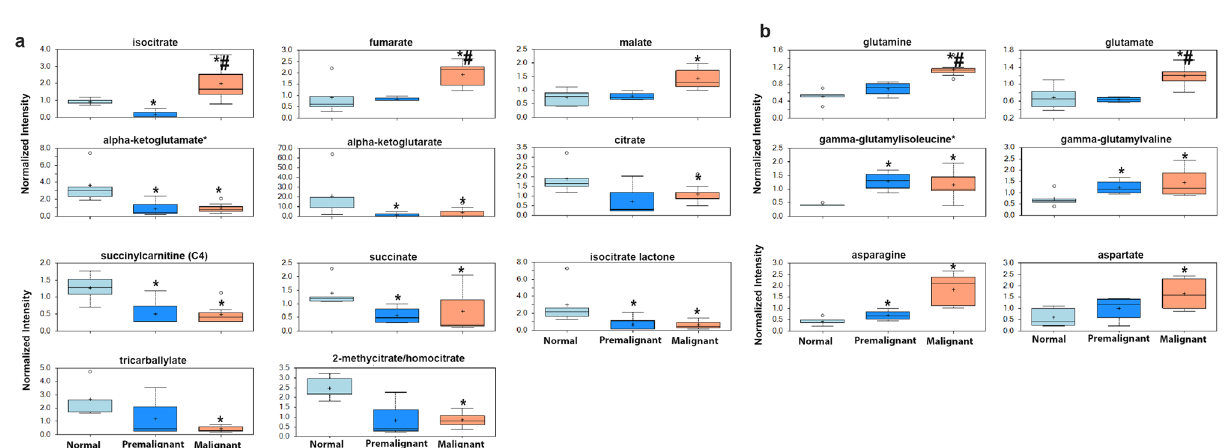
Figure 9. Glycolysis in premalignant and early malignant bladder lesions: ( a ) The expression of glucose and glycolysis intermediate and end metabolites. * p < 0.05 compared to normal. # p < 0.05 comparing premalignant to malignant lesions. ( b ) Transcript expression of HK2 and SLC2A1 (glucose transporter 1) in NMI tumors compared to normal urothelium in TCGA, GSE13507 , MSKCC, and GSE3167. p -values were determined by one way ANOVA ( a ), and Student’s t -test ( b ).